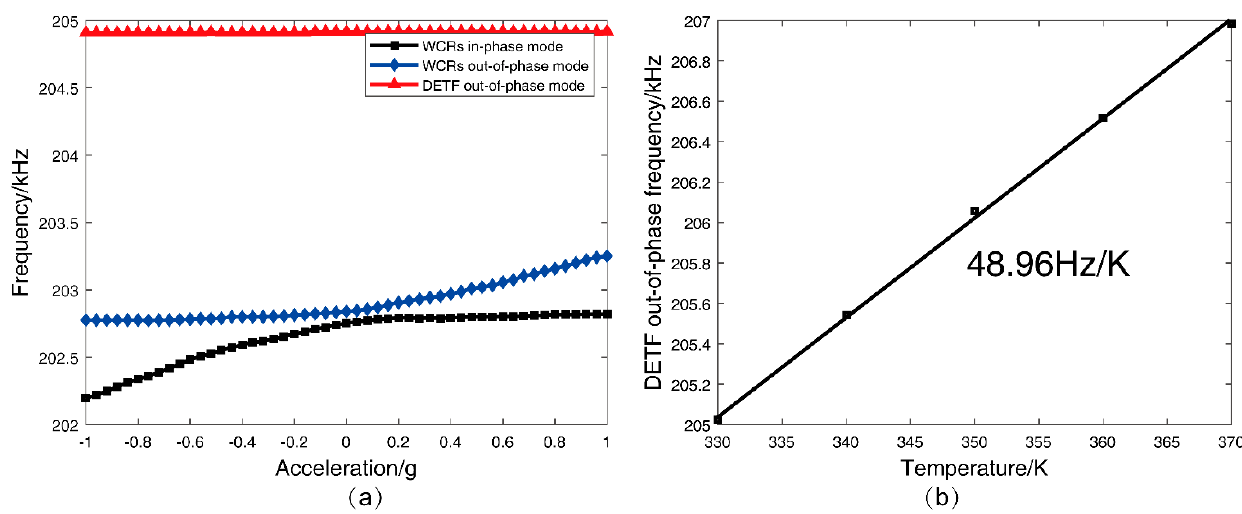
Figure 12. ( a ) The experimental results of the DETF-CC WCRs three mode frequency shift with the acceleration from – 1 g to +1 g ; ( b ) the frequency of DETFs out-of-phase versus temperature at 0 g .